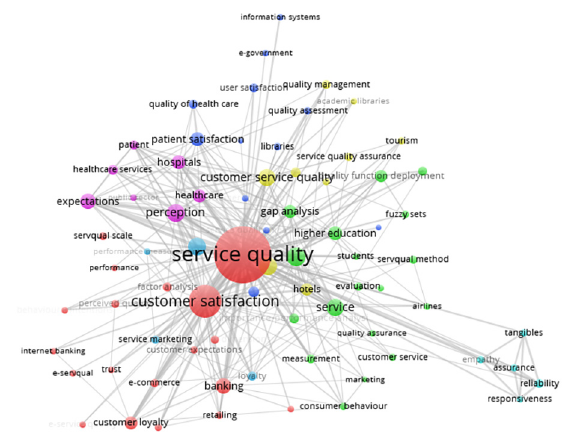
Figure 3. Keyword co-occurrence map characterizing the SERVQUAL context-related ap-plications indexed in the Scopus database from 1989 to